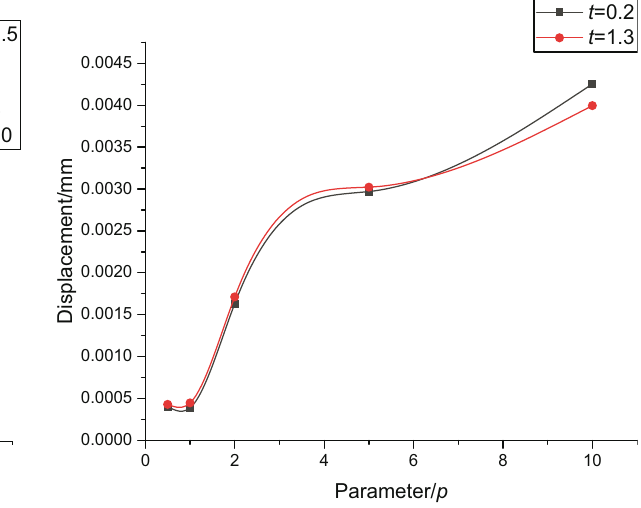
Figure 7: Overall displacement changes with the gradient